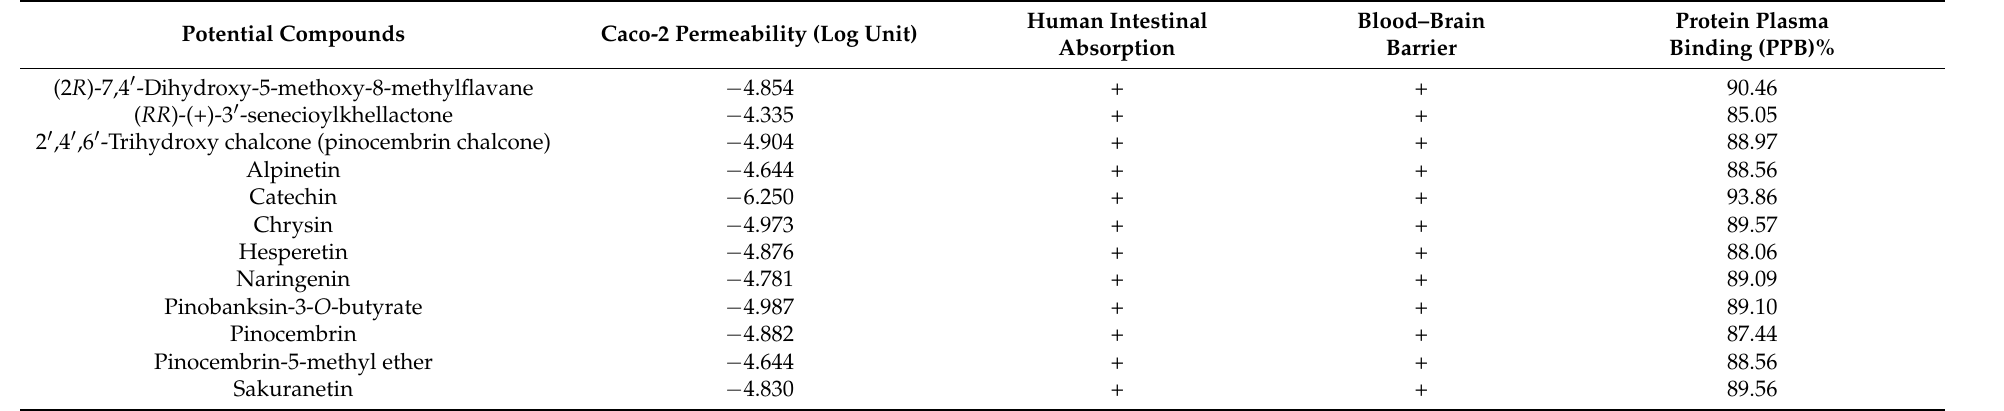
Table 5. Predicted pharmacokinetic properties of potential compounds from Asian